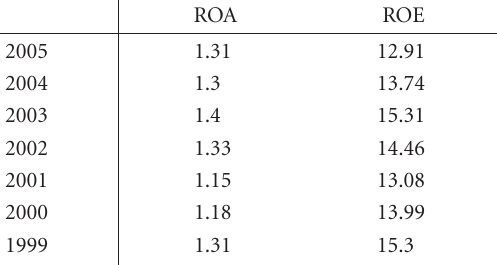
Table 4.1. Source FDIC-insured institutions.